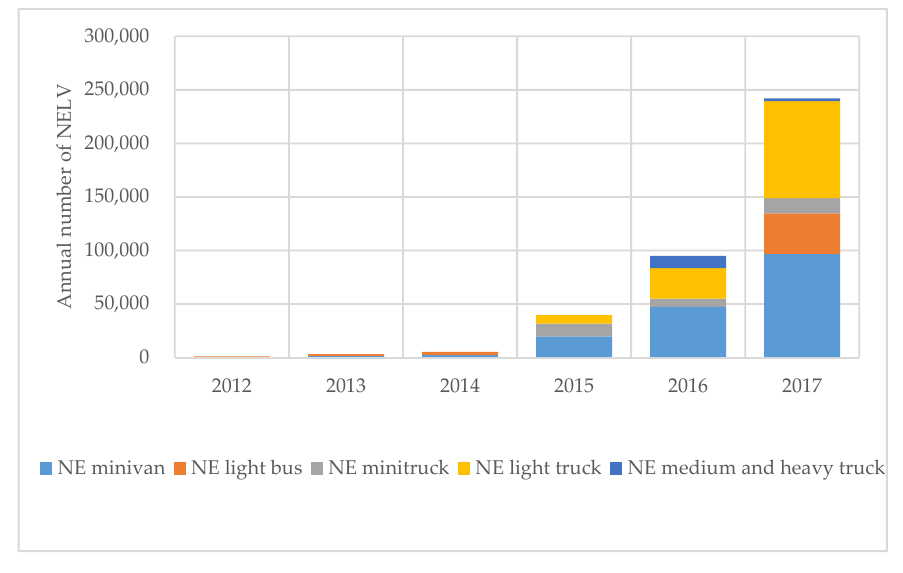
Figure 5. Annual numbers of the various types of NELVs.